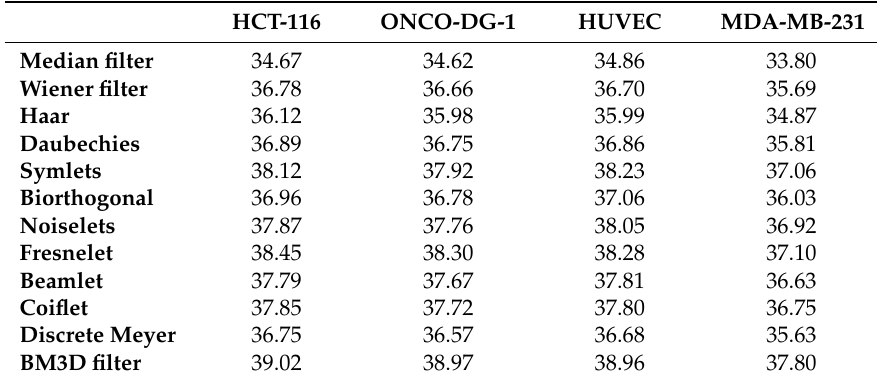
Table 2. SNR values resulting from the application of different filters to depth maps obtained from cell